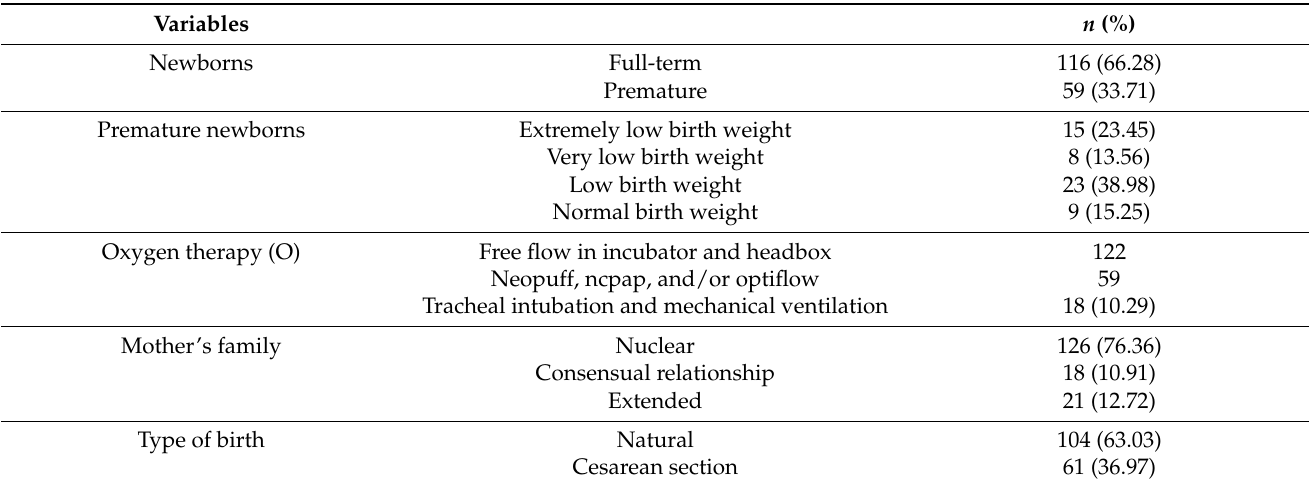
Table 1. Neonatal and maternal variables.